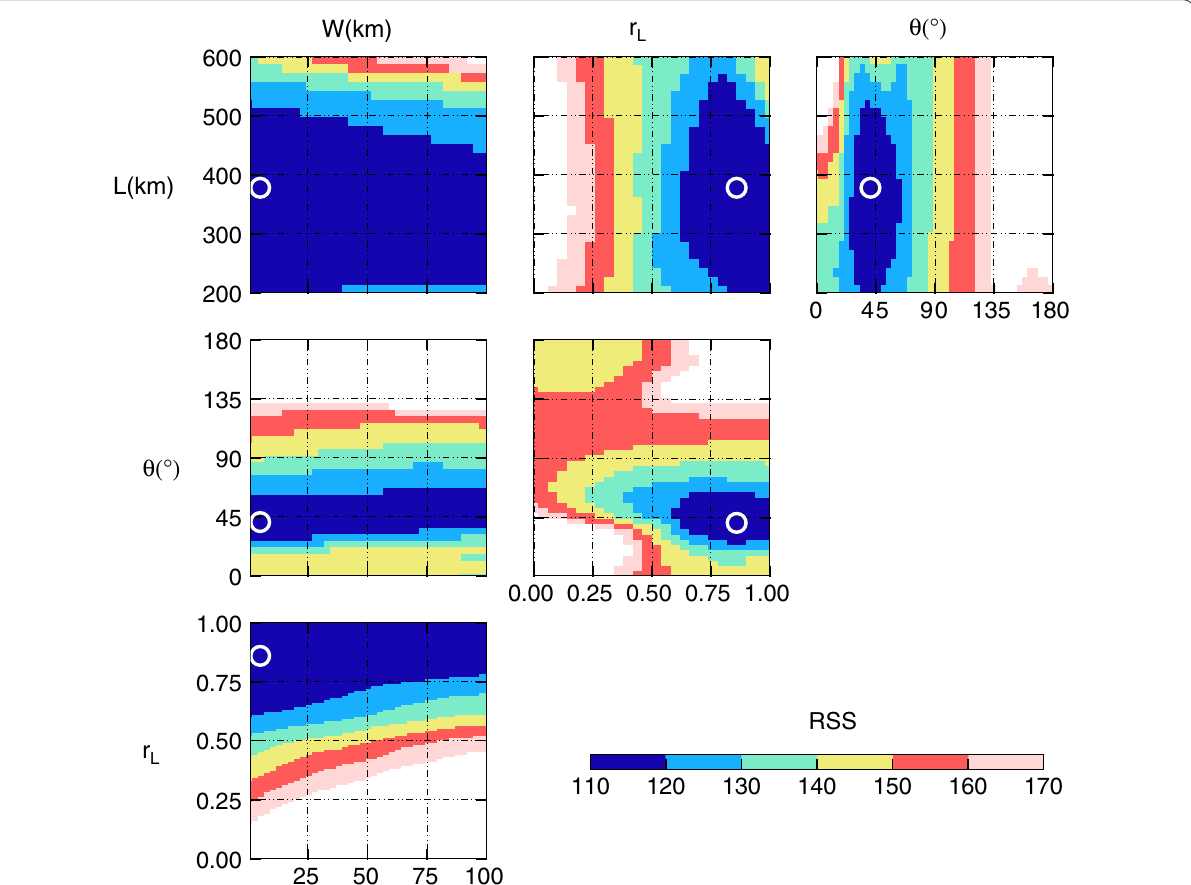
Fig. 12 Residual surface of the four model parameters ( L , W , θ , and r L ) at 125 s after the origin time for the 2008 Wenchuan earthquake. The format is the same as in Fig.